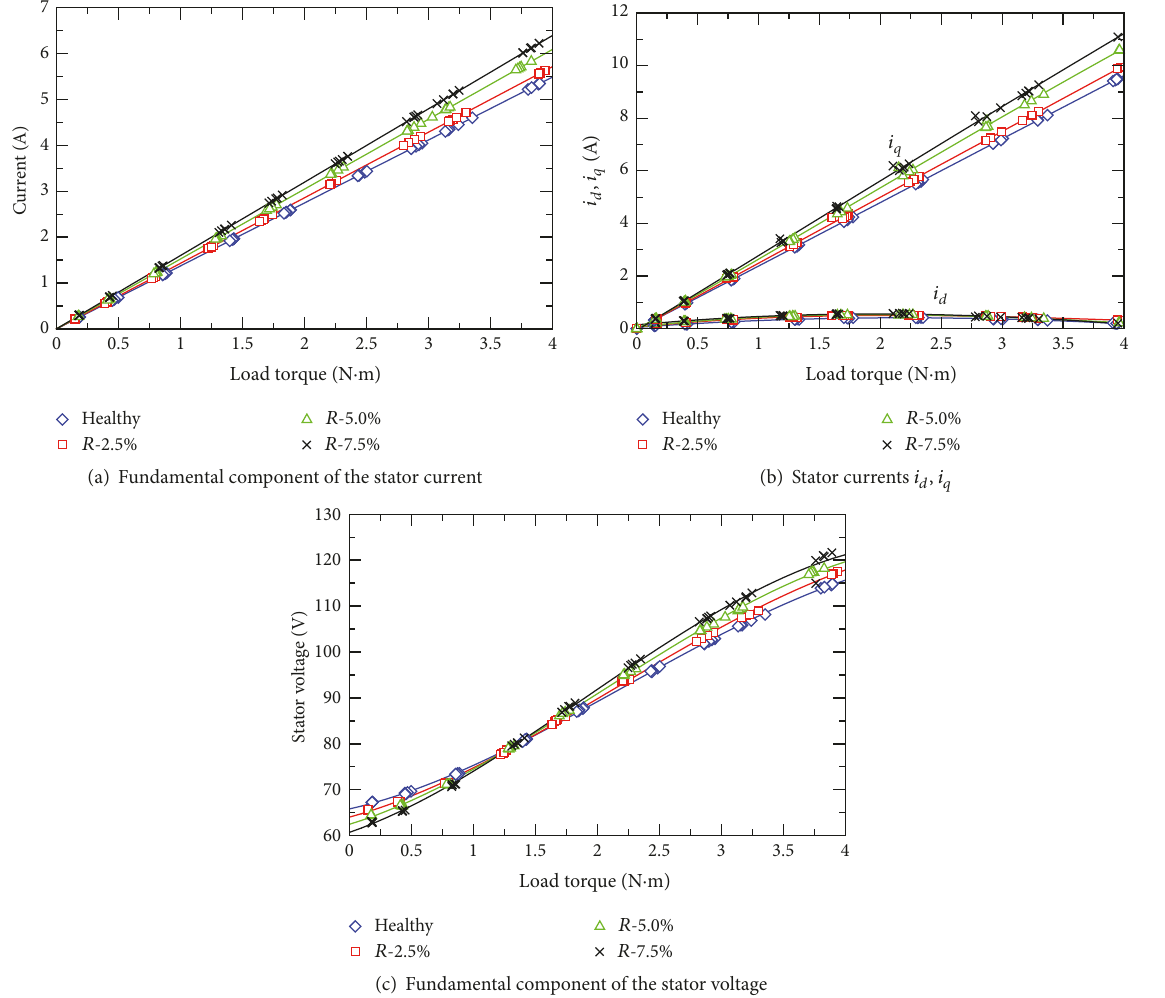
Figure 21: Measurement results under vector